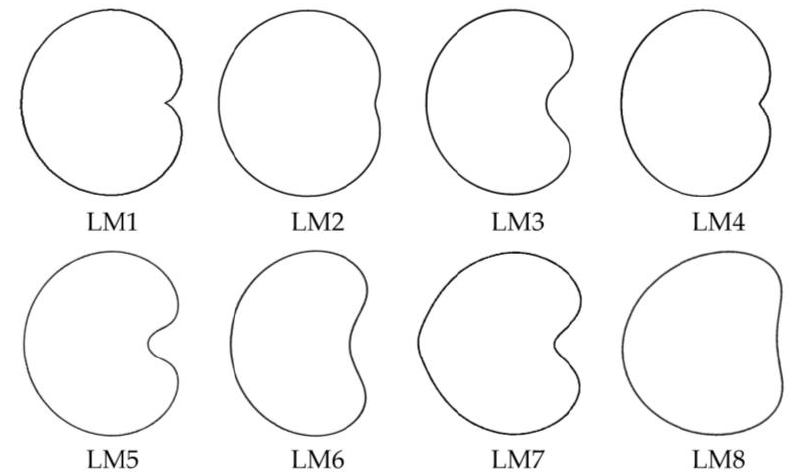
Figure 1. Lateral models (LM) used in this work, taken from [14].